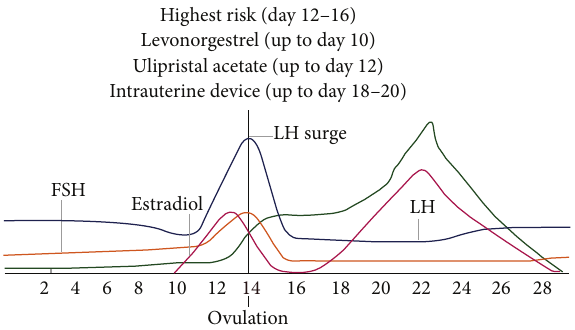
Figure 1: Fertility risk and window of action of different methods of emergency